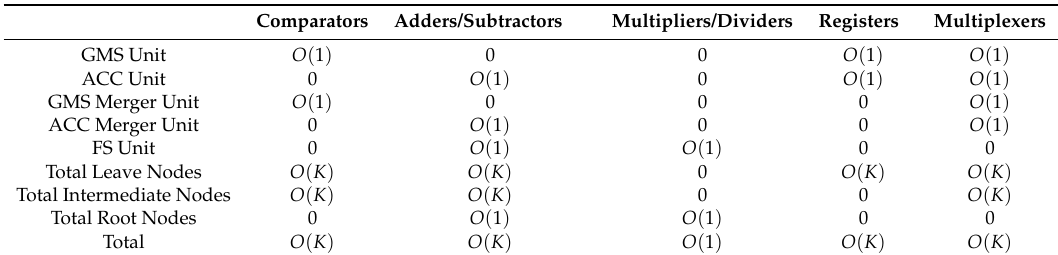
Table 1. The area complexities of the proposed feature extraction